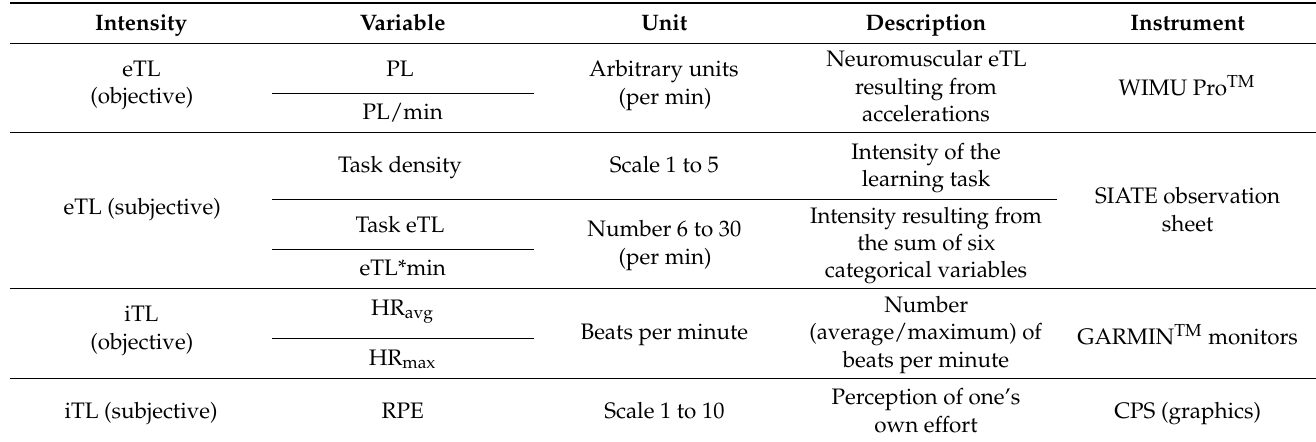
Table 3. Summary of study variables and